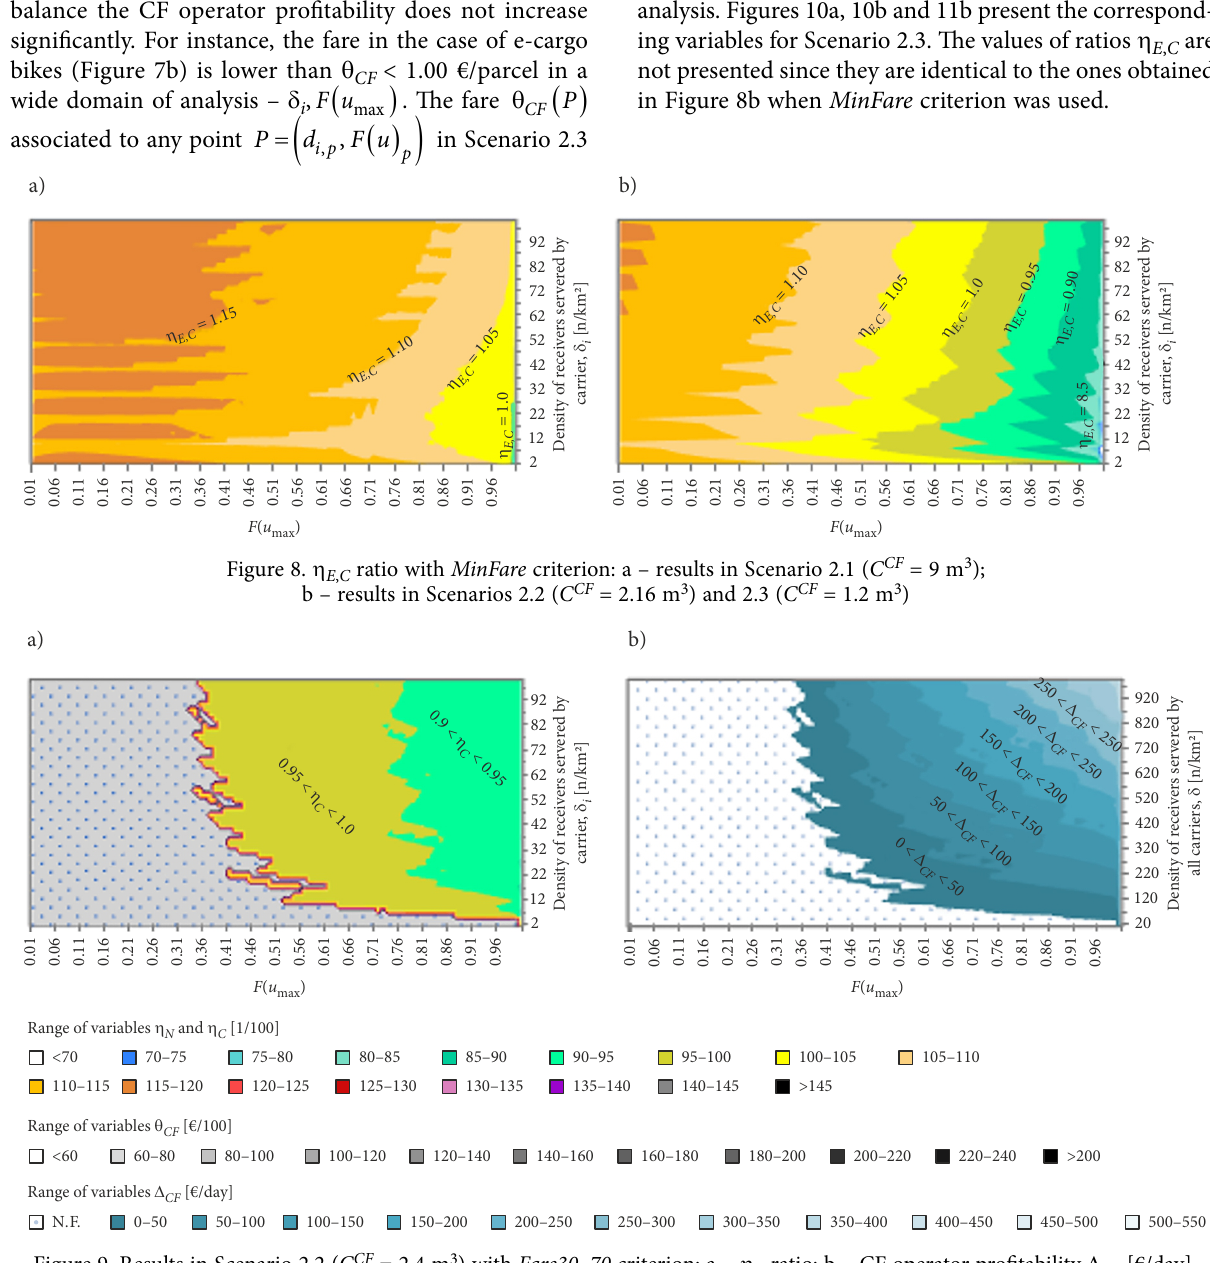
Figure 9. Results in Scenario 2.2 ( C CF = 2.4 m 3 ) with Fare30–70 criterion: a – h C ratio; b – CF operator profitability D CF